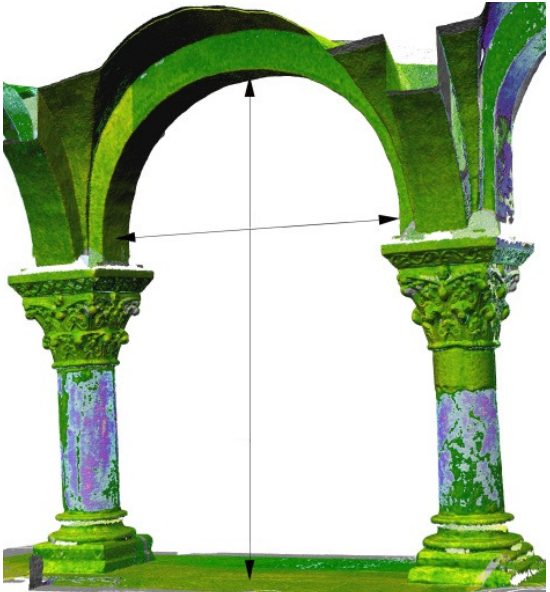
Figure 16. Dimensional